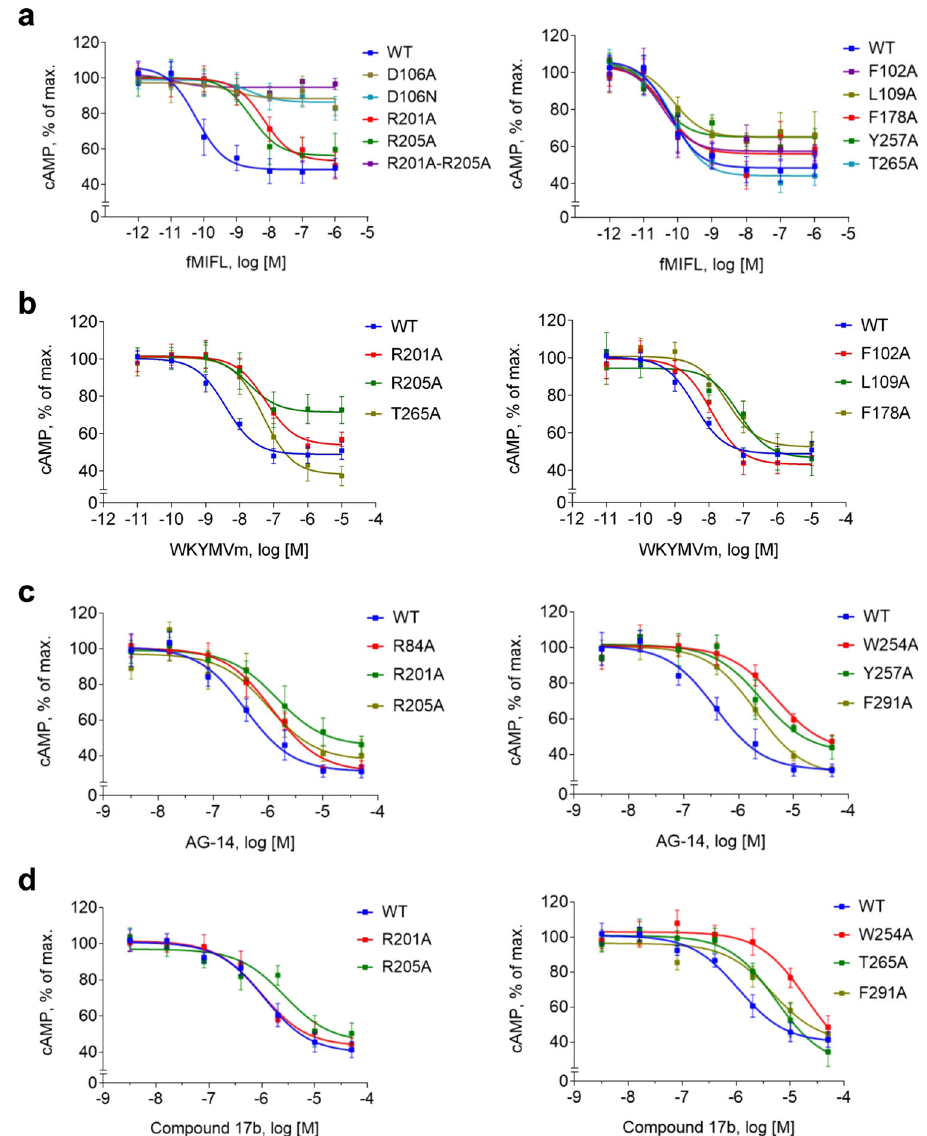
Fig.5|Dose-responsecurvesofFPR1anditsmutantsincAMPinhibitionassays. FPR1 and selected mutants were expressed in transiently transfected cells. The receptors were stimulated with different concentrations of the indicated agonists, fMIFL ( a ), WKYMVm ( b ), AG-14 ( c ) or Compound 17b ( d ) plus forskolin for 30min.